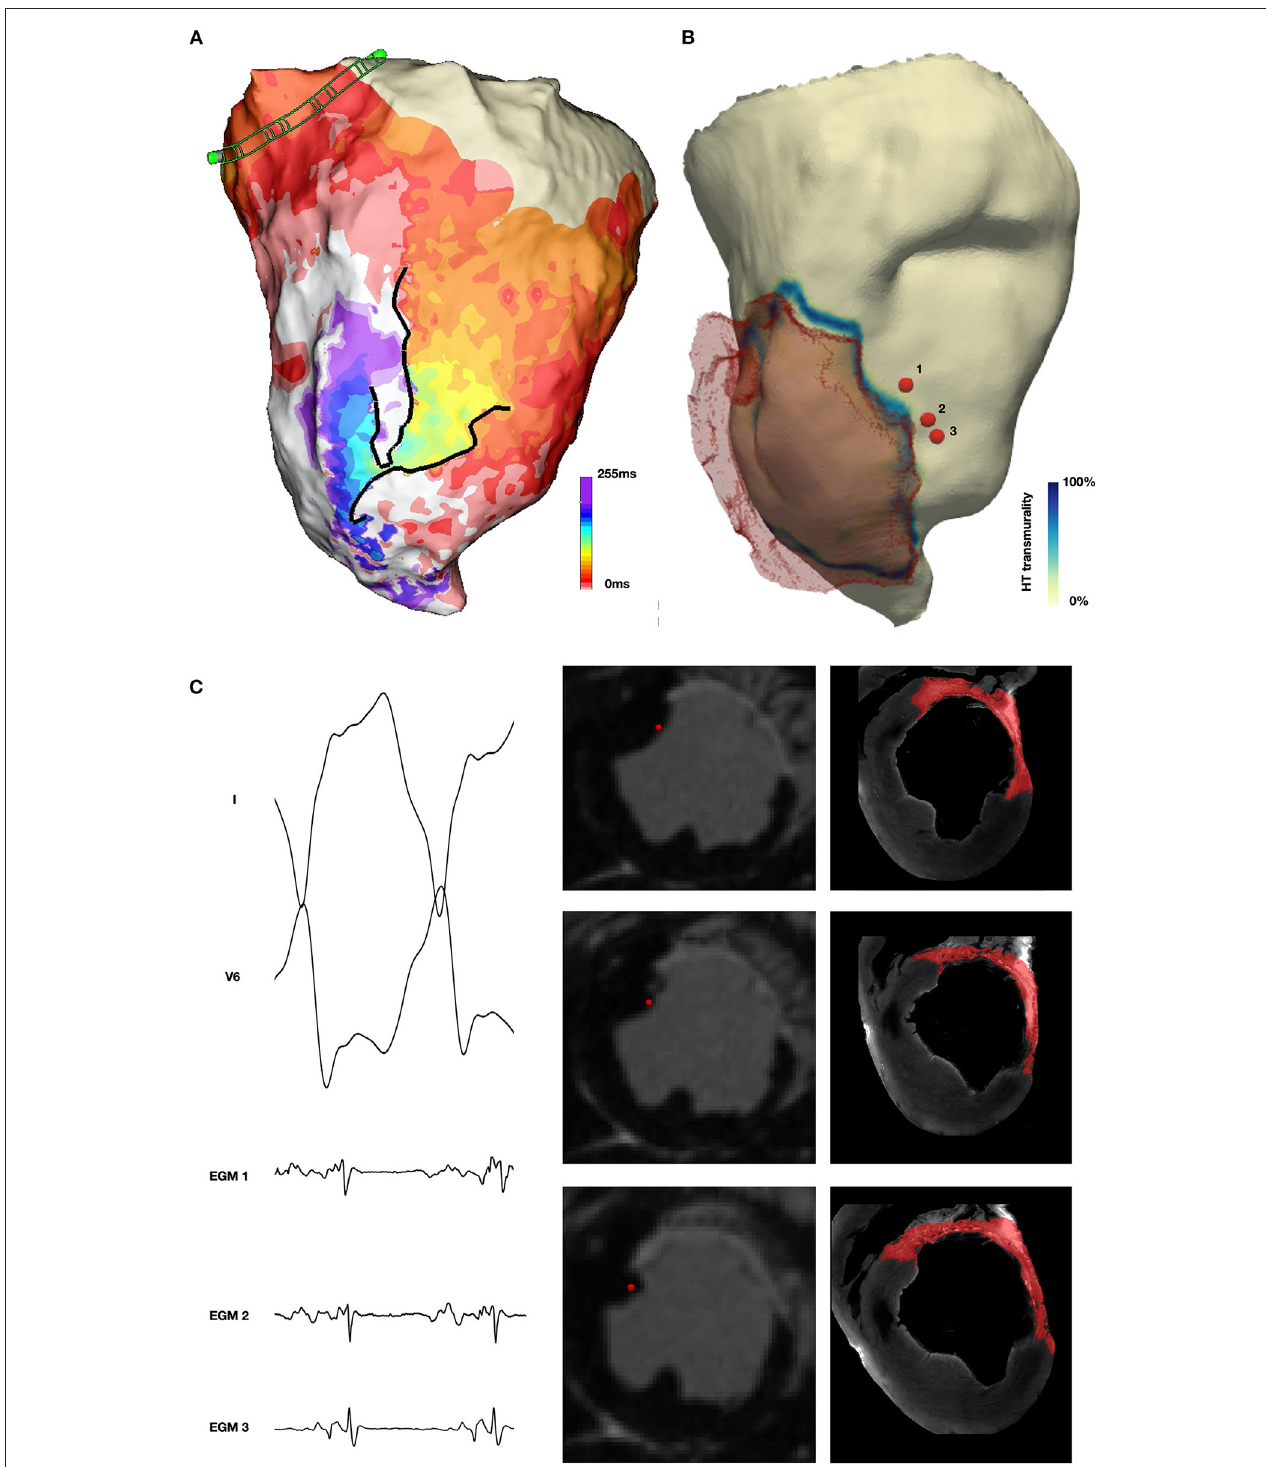
FIGURE 6 | Non-scarred tissue demonstrating diastolic activation during VT. (A) Activation map during VT demonstrating diastolic activation during VT (yellow to purple) with a converging pattern of activation toward a narrow channel (green) which subsequently widens prior to multiple systolic breakouts (red). (B) In-vivo CMR derived shell with translucent mesh of scar overlaid and color coded according to HT transmurality. The location of 3 early diastolic EGMs is indicated by red spheres. (C) Early diastolic EGM, short axis (SAX) in-vivo CMR and corresponding EACI imaging at locations 1, 2 and 3 demonstrating location of EGMs in tissue proximal to scar, but without enhancement in the wall at this